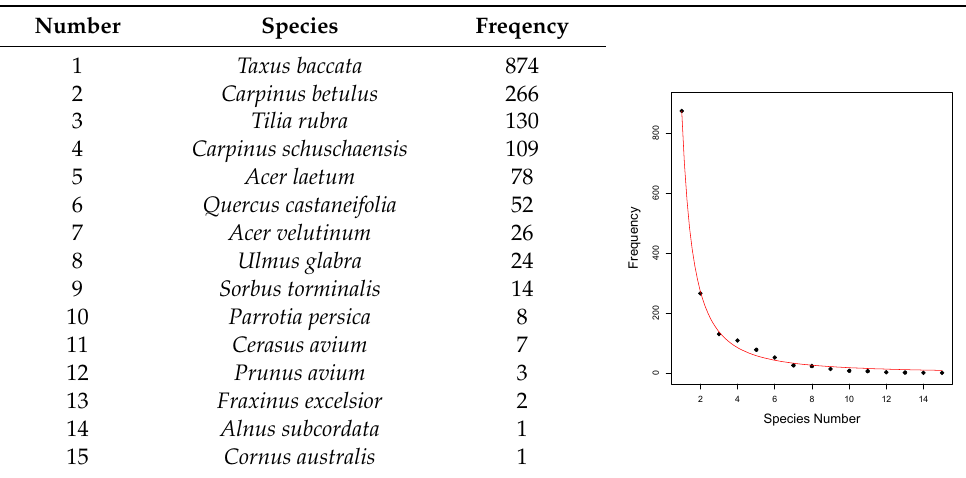
Table 3. Species abundance distribution of the three Hyrcanian forest plots combined. Two species ( Taxus baccata and Carpinus betulus ; species 1 and 2) are very abundant, two species are rare ( Parrotia persica ; Cerasus avium , species 10 and 11), and four species are very rare ( Prunus avium ; Fraxinus excelsior ; Alnus subcordata ; Cornus australis ; species 12 to 15).